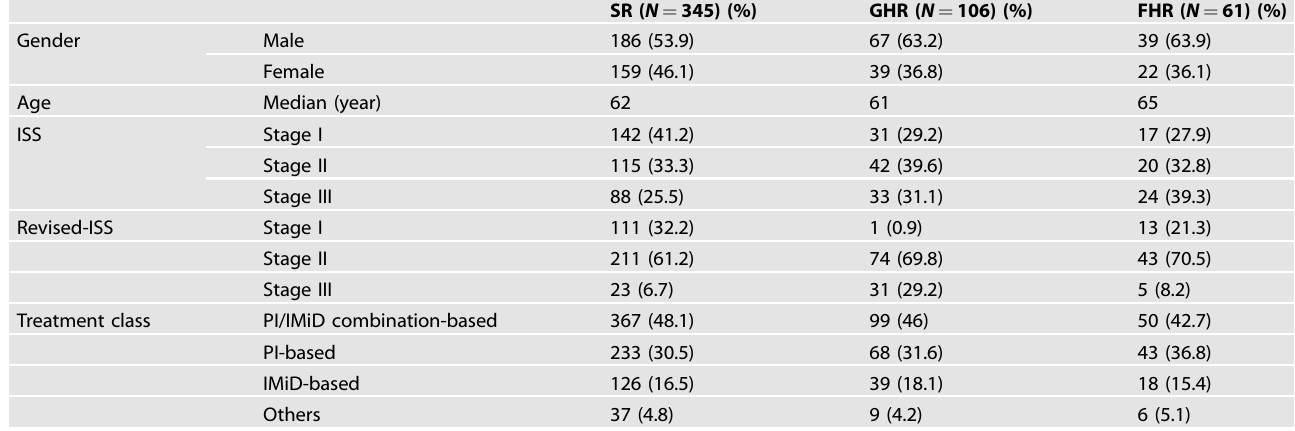
SR Standard Risk group, GHR Genomic High-Risk group, FHR Functional High-Risk group, ISS International Staging System, PI Proteasome Inhibitor, IMiD Immunomodulatory Drug. Data are number